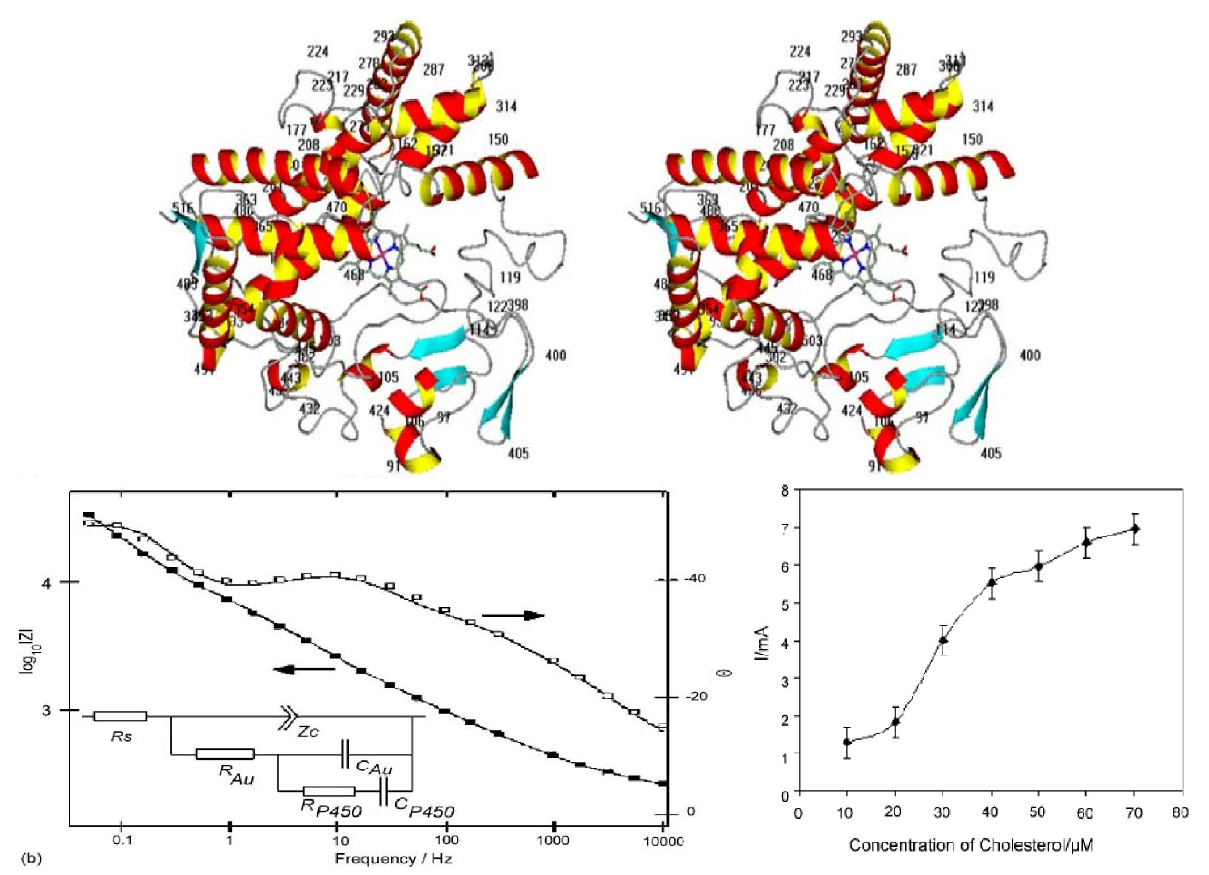
Figure 8. Above: Stereo view of homology model of Cytochrome P450scc, based on Cytochrome 450 2B4. Acidic amino residues are labeled. Secondary structure elements are colored. Heme is shown as sticks. Center: The impedance characteristic for an Au–P450scc electrode in 100 mM phosphate buffer, 50 mM KCl, pH 7.4. The lines show the best fit to the experimental data. The insets present the equivalent circuits fitting the impedance data. RS is the uncompensated solution resistance; ZC is the double layer capacitance; RAu and CAu are the ohmic and capacitive contributions respectively of the gold nanoparticles on the electrode to the impedance, while RP450 and CP450 are the same contributions respectively to the impedance due to presence of cytochrome P450scc on the electrode. Both plots represent the phase (□) and the modulus (■) vs. frequency. Below: The amperometric response of screen-printed rhodium–graphite Au–P450scc electrode to increasing cholesterol concentration. About 100 µM stock solution in 0.3% sodium cholate, measured when fractions of 10 µM of cholesterol has been repeatedly added. The total volume of electrolyte was 60 µL. The current was measured at